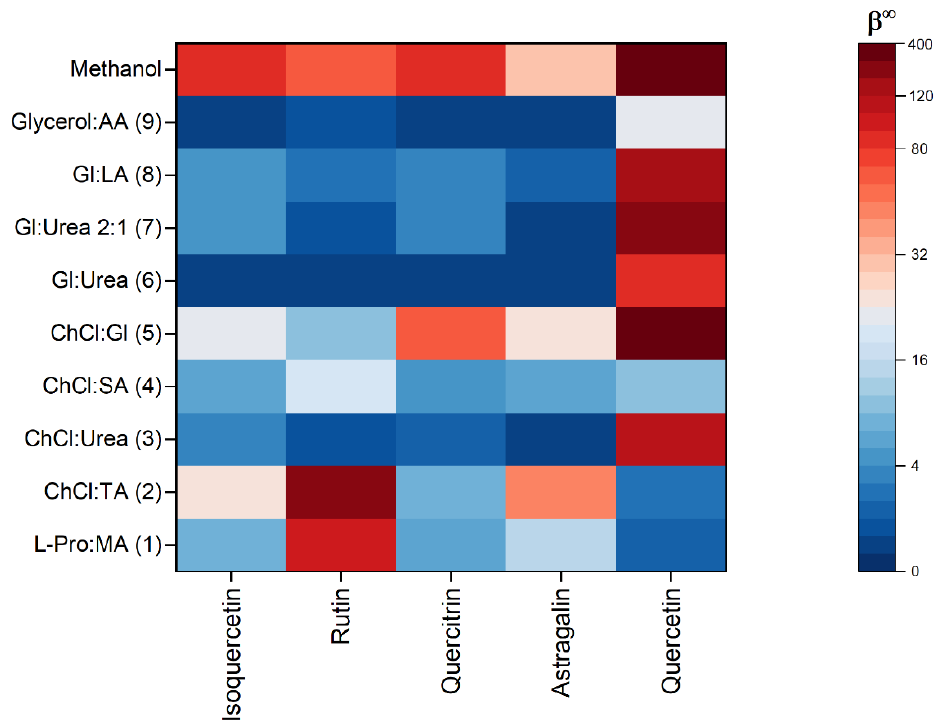
Figure 2. The solvent–solute affinity parameter β ∞ for five solutes (x ‐ axis) in ten solvents (y ‐ axis). Higher values for β ∞ imply better mutual affinity, i.e. , higher extractability. The mol ratio of HBD and HBA in the NADES is 1:1 in all solvents except NADES7 (glycerol: urea 2:1). The abbreviations L ‐ Pro, MA, ChCl, TA, SA, Gl, LA, and AA denote L ‐ proline, maleic acid, choline chloride, tartaric acid, succinic acid, glycerol, lactic acid, and L ‐ ascorbic acid, respectively.